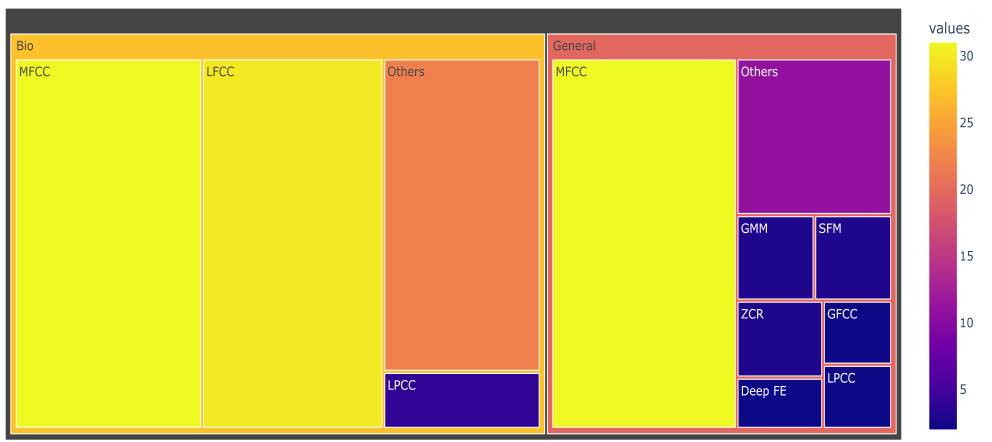
Figure 11. Feature extraction techniques used in bioacoustics and general acoustics